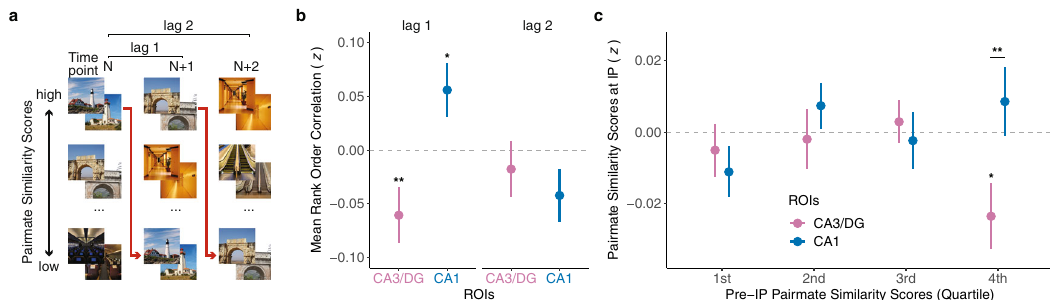
Fig. 3 Representational structure across timepoints. a Schematic illustration showing the rank order of scene pairmates based on pairmate similarity scores at various time points ( N , N + 1, N + 2). If scene pairmates with relatively high pairmate similarity scores at a given timepoint are systematically associated with relatively low pairmate similarity scores at a succeeding time point (red arrows), this will produce a negative rank correlation. b Mean rank order correlations of pairmate similarity scores across timepoints for CA3/dentate gyrus (CA3/DG, pink) and CA1 (blue). Lag 1 correlations re fl ect correlations between a given timepoint and an immediate succeeding timepoint (e.g., timepoints 2 and 3). Lag 2 correlations re fl ect correlations between a given timepoint and a timepoint two steps away (e.g., timepoints 2 and 4). At lag 1, there was a negative correlation in CA3/dentate gyrus ( p = 0.006, two-tailed one-sample t -test), but a positive correlation in CA1 ( p = 0.043, two-tailed one-sample t -test). At lag 2, correlations were not signi fi cant in either CA3/dentate gyrus ( p = 0.485, two-tailed one-sample t -test) or CA1 ( p = 0.120, two-tailed one-sample t -test) indicating that correlations in the representational structure were speci fi c to temporally adjacent rounds. c Pairmate similarity scores at the in fl ection point (IP) as a function of relative pairmate similarity scores in the pre-IP state ( fi rst quartile = lowest similarity, fourth quartile = highest similarity). Pairmate similarity scores in CA3/ dentate gyrus were signi fi cantly lower than CA1 ( p = 0.008, two-tailed paired samples t -test) and signi fi cantly below 0 ( p = 0.017, two-tailed one-sample t -test) for pairmates with the highest pre-IP similarity (fourth quartile). See Supplementary Fig. 4 for the distributions of pre-IP pairmate similarity